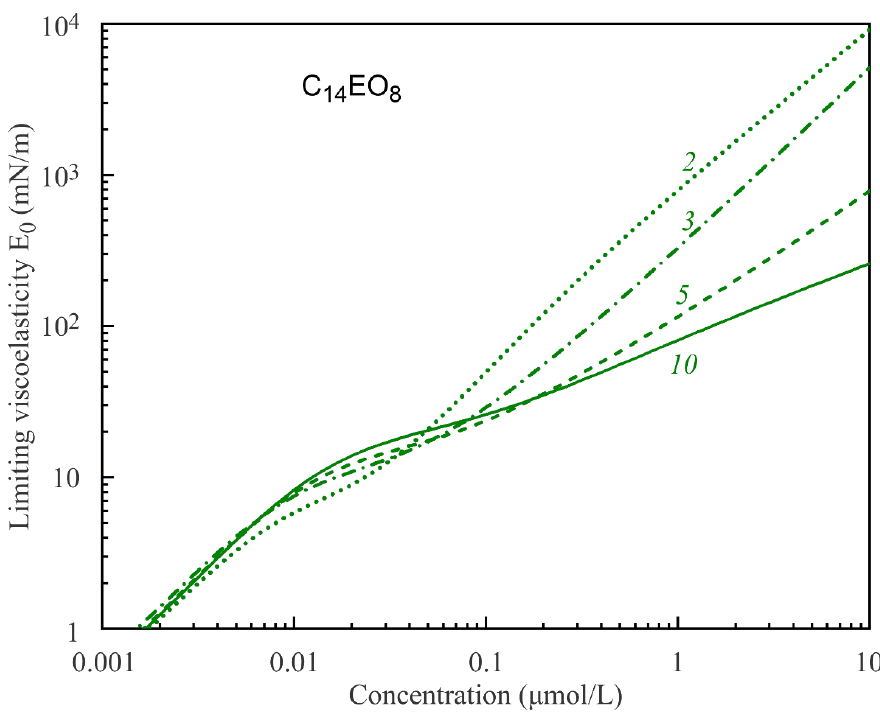
Figure 5. Limiting elasticity E 0 for C 14 EO 8 solutions calculated assuming various number of states s with the parameter sets presented in Table 2. For details see text.